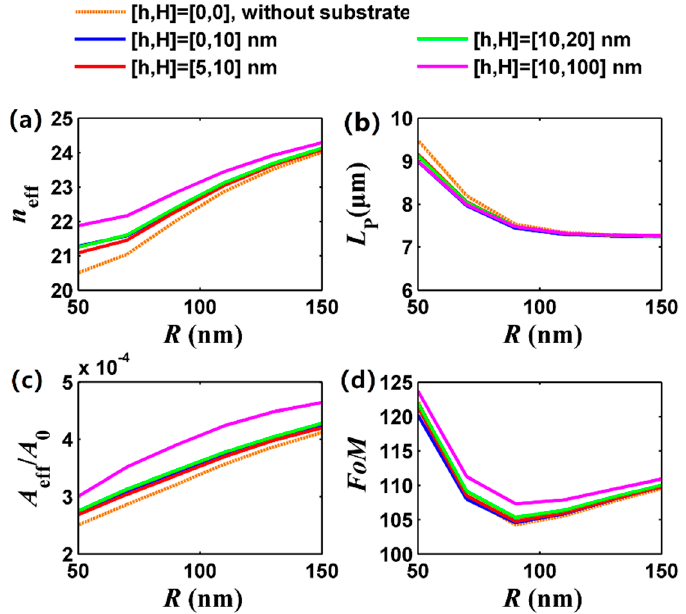
Figure 4. Dependence of the FGPM properties on nanowire radius R ( R 1 = R 2 = R ) at 30 THz. ( a ) Effective mode index; ( b ) propagation length; ( c ) normalized mode size; and ( d ) FoM. The dotted brown curve for [ h , H ] = [0,0], solid blue curve for [ h , H ] = [0,10] nm, solid red curve for [ h , H ] = [5,10] nm, solid green curve for [ h , H ] = [10,20] nm, and solid pink curve for [ h , H ] = [10,100] nm. Other parameters are the same as Figure 2.